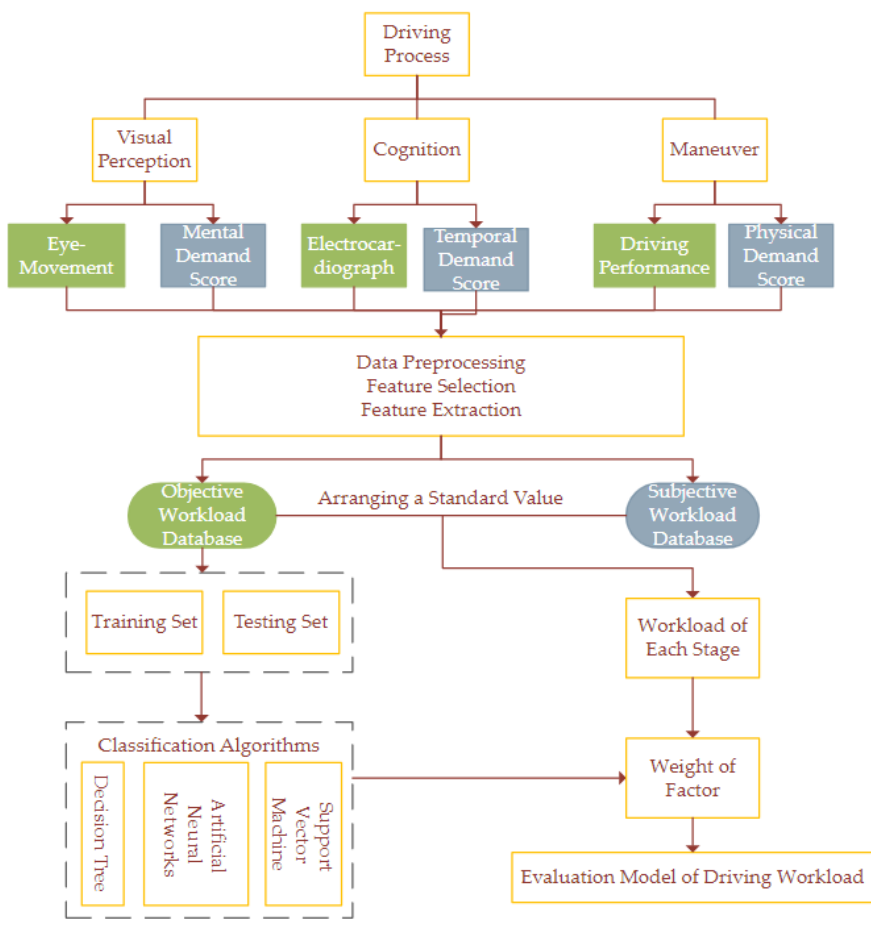
Figure 3. Modeling framework for the evaluation method of the driving